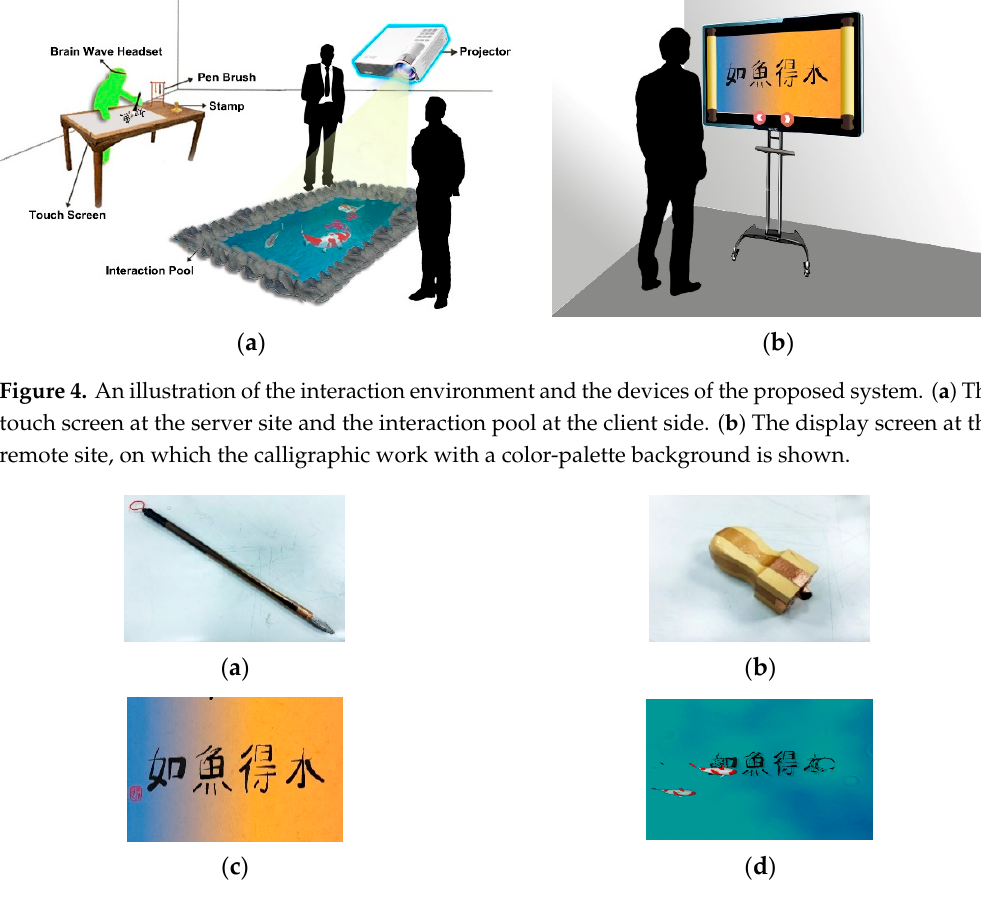
Figure 5. Tools used by the proposed system and calligraphic works with color-palette and animation backgrounds created in the interaction process. ( a ) The pen brush. ( b ) The stamp. ( c ) A calligraphic work with a color-palette background shown on the touch screen (with the four characters meaning “like a duck to water”). ( d ) A calligraphic work with an animation background shown on the panel of the interaction pool.